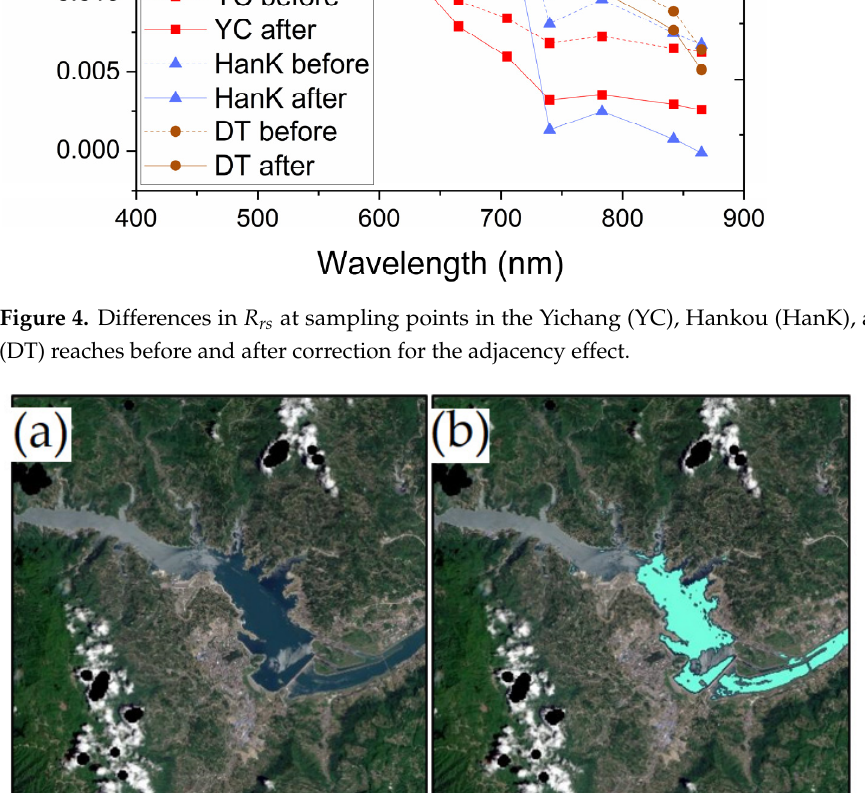
Figure 4. Differences in R rs at sampling points in the Yichang (YC), Hankou (HanK), and Datong (DT) reaches before and after correction for the adjacency effect.